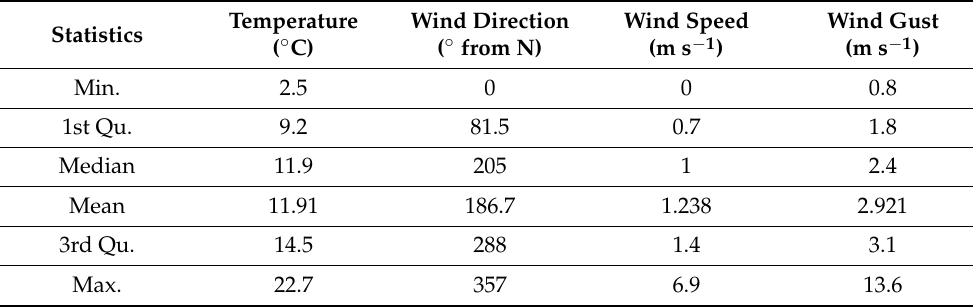
Table 2. Main statistics of the meteorological variables used in the present simulations: minimum, 1st and 3d quartiles, median, mean, and